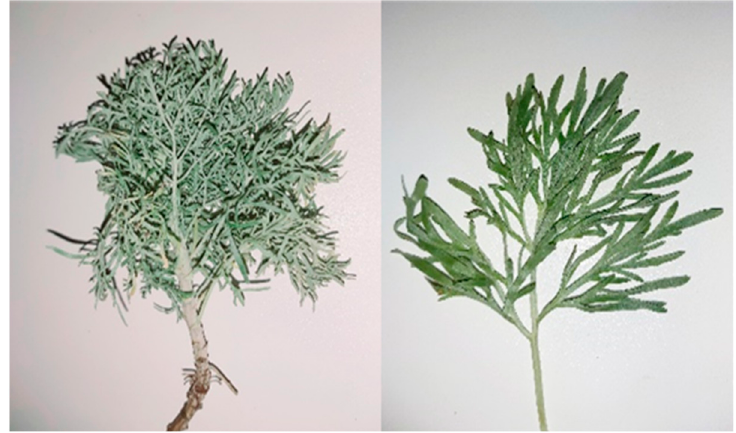
Figure 1. A. absinthium herb.